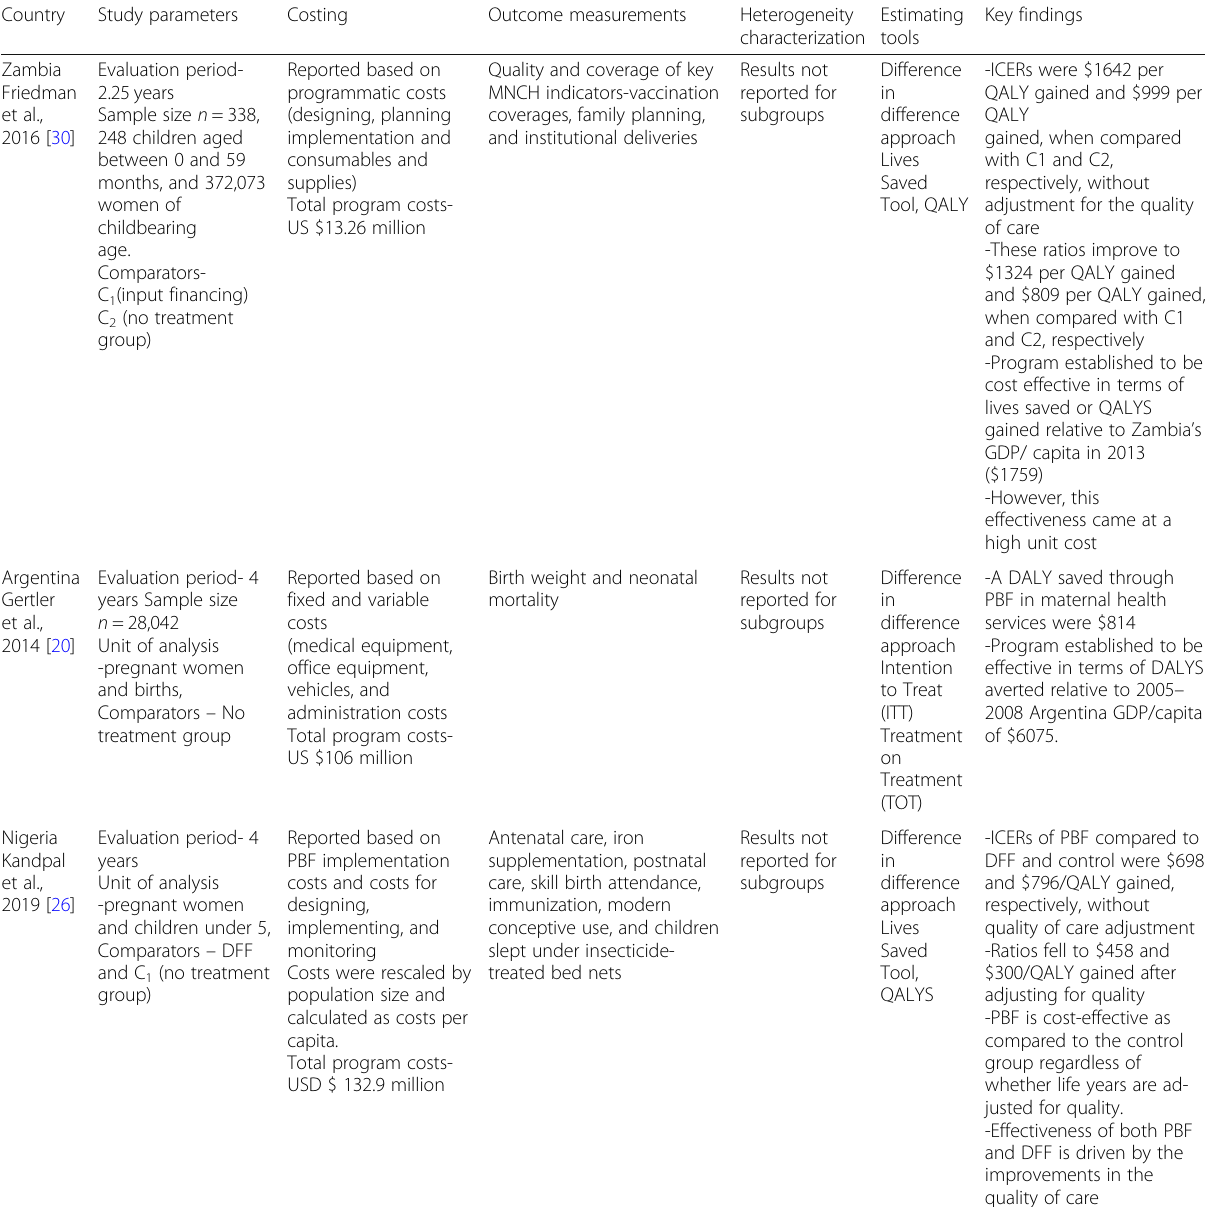
Table 4 Economic evaluation results - CHEERS model Country Study parameters Costing Outcome